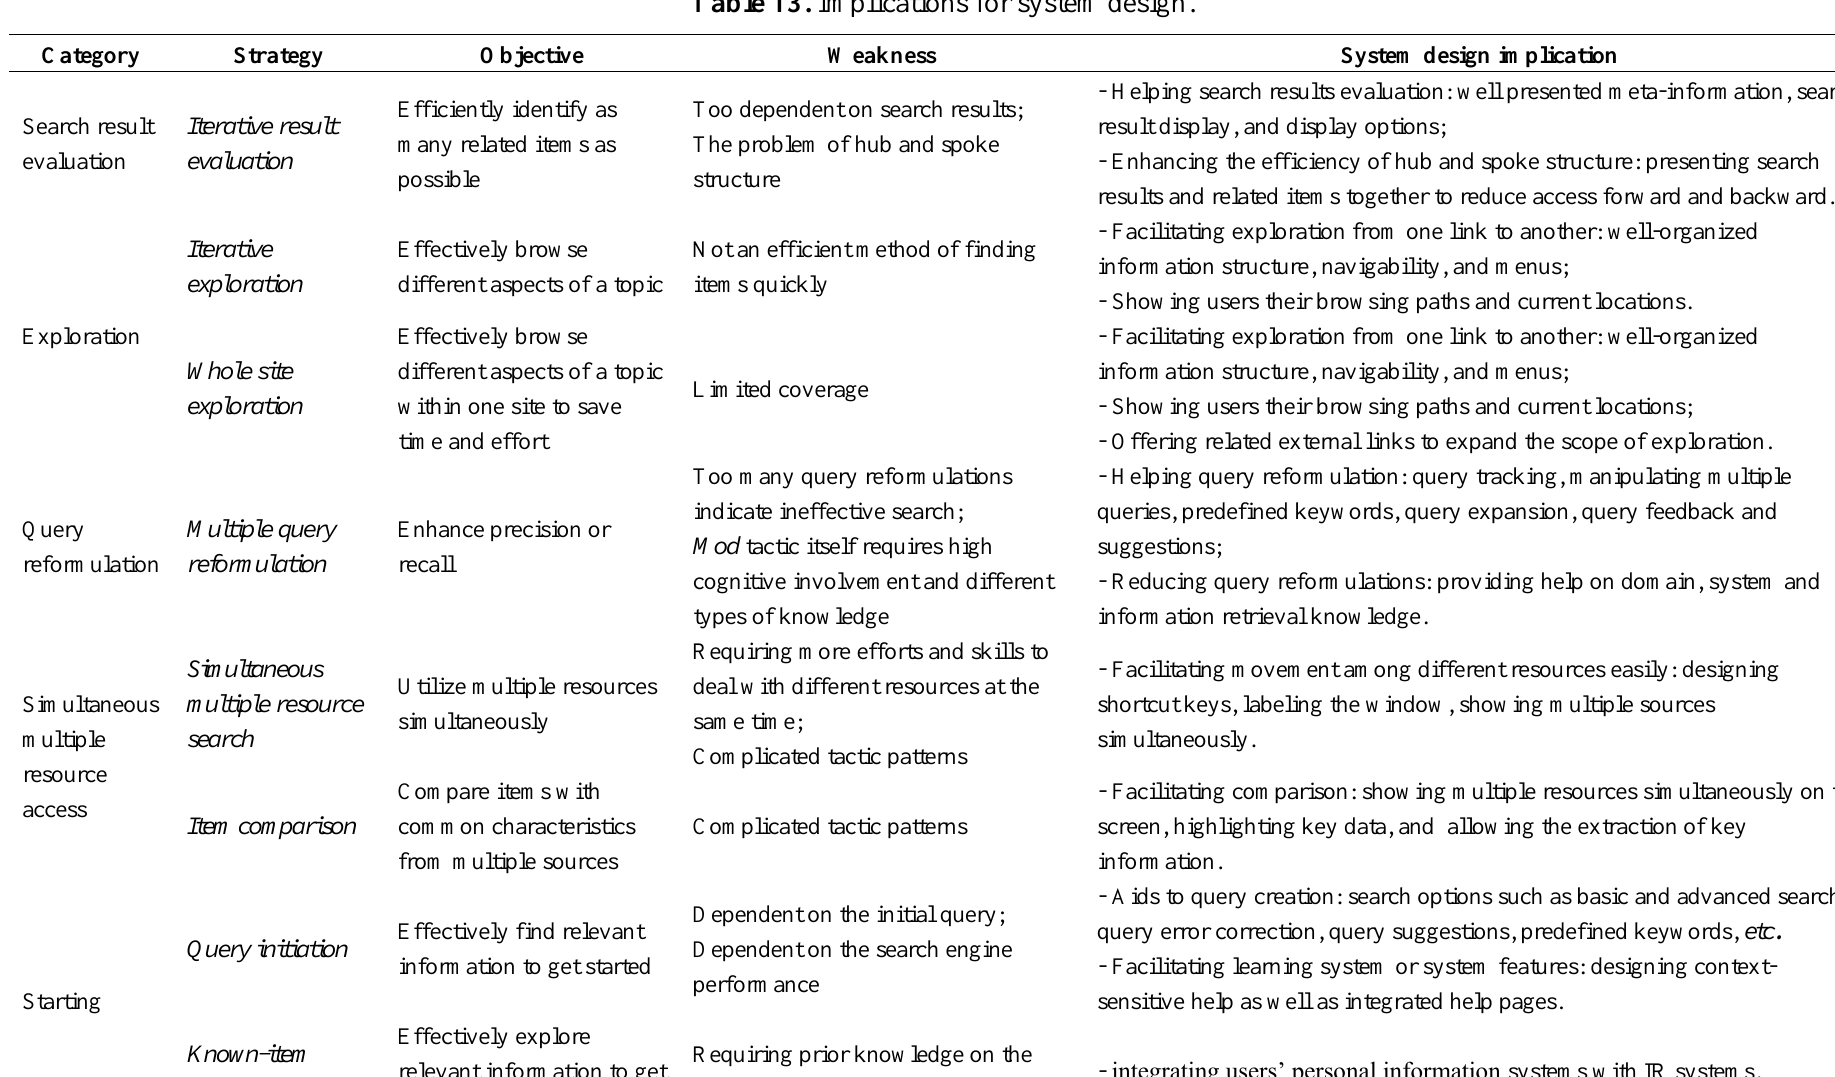
Table 13. Implications for system